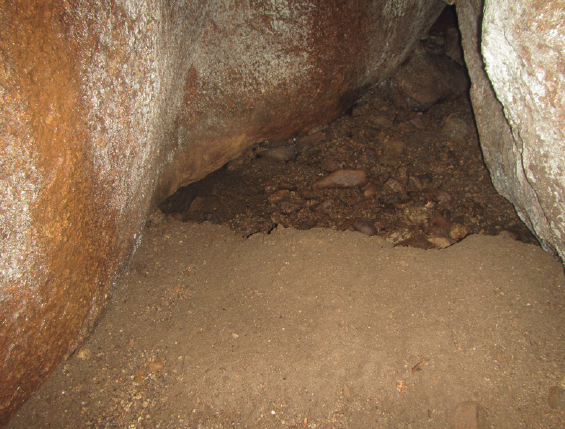
Figure 8. Caverna Laje Branca, Iporanga, São Paulo state, Brazil. Photo by D. Menin.